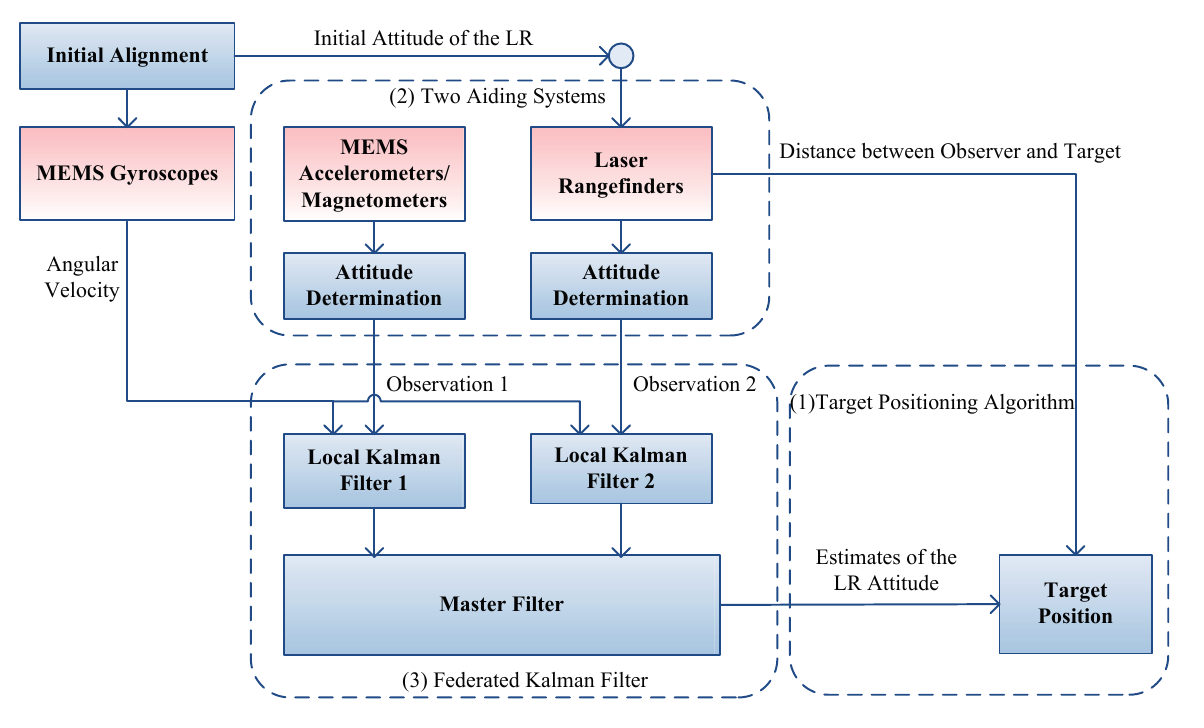
Figure 1. Structure of the proposed target positioning